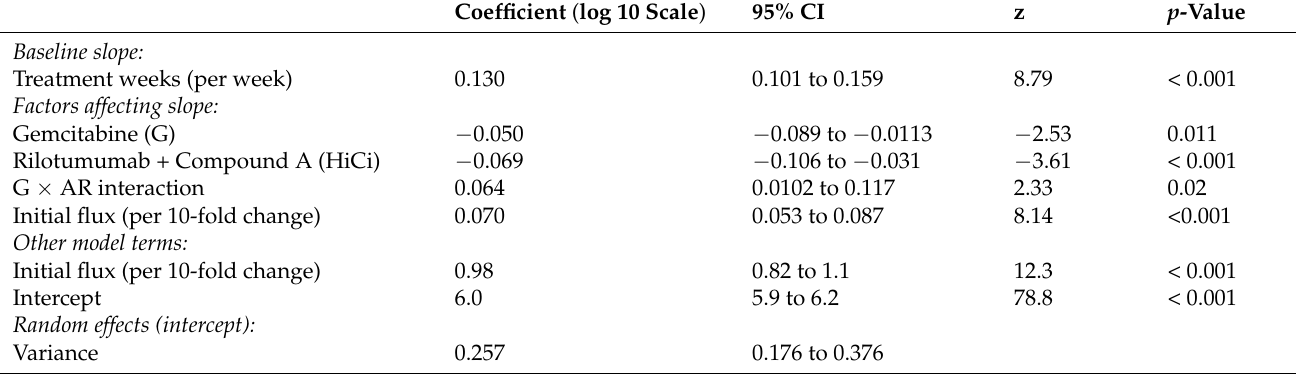
Table A2. Model specification for Figure 1a: mixed-effects model for longitudinal analysis of tumour burden for all mice. ( a ) Multivariate model of the ventral radiant flux of mice. The coefficients represent the log10 value of the n-fold change associated with one unit change in the covariate. To make this model easier to interpret, the initial flux value was centred around 10 6 p/s (that is, 10 6 is 0, 10 7 is 1, etc.). ( b ) As the model may be confusing for the reader, this table shows the predicted rates of progression under various conditions (according to this model). The rate of progression is in this table expressed as n -fold changes of ventral radiant flux per week. ( a ) Multivariate model for disease progression, as measured by ventral radiant flux, over